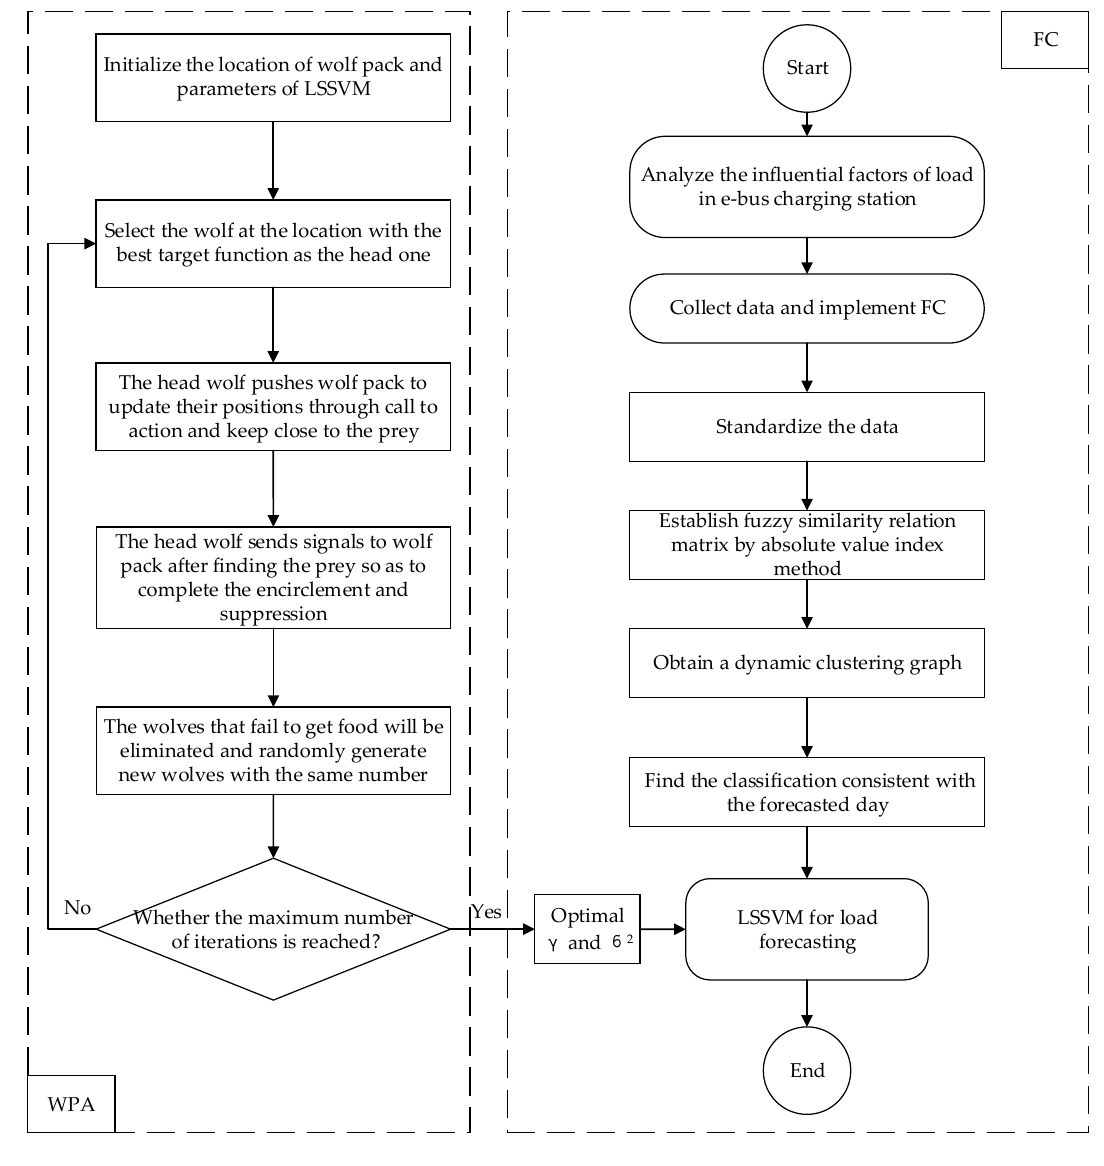
Figure 6. The flow chart of the proposed forecasting model.